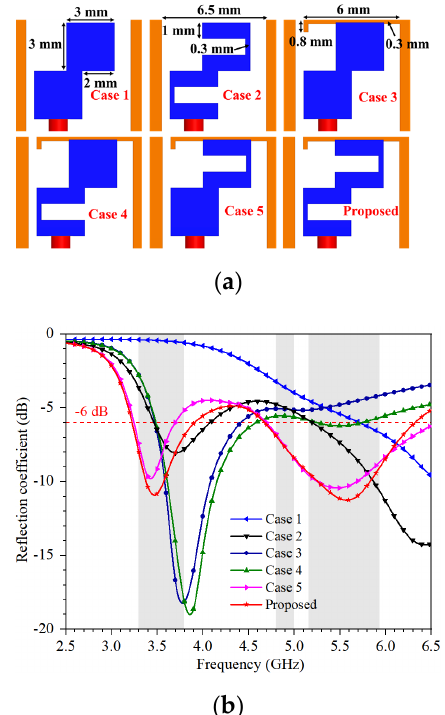
Figure 2. Design evolution of antenna element: ( a ) The evolution shapes; ( b ) The reflection coeffi- cient.